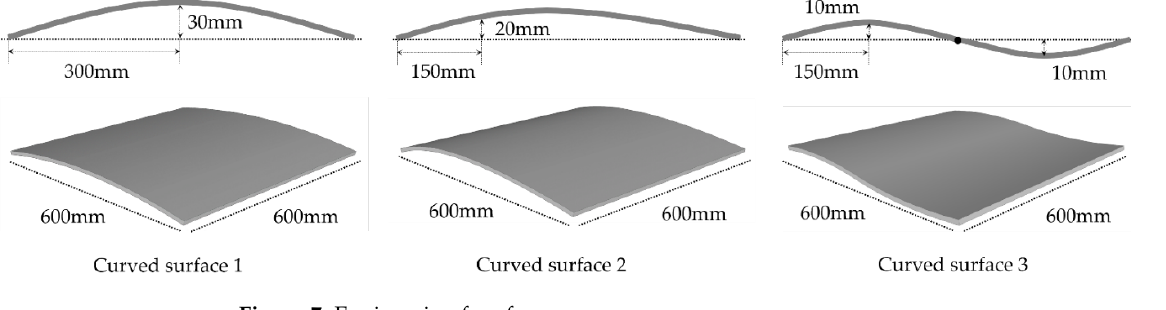
Figure 7. Engineering free-form curves.